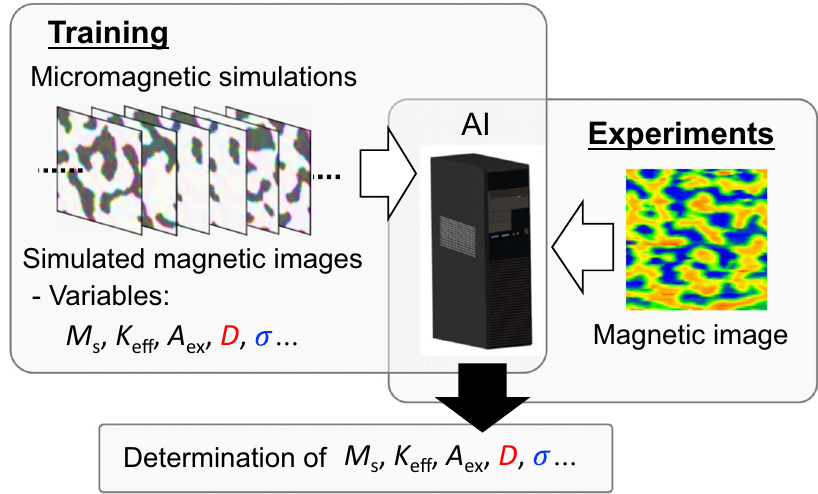
Fig. 1 Concept of the study. Micromagnetic simulations are used to generate thousands of training images. There are fi ve relevant material parameters: M s , K eff , A ex , D , and σ . Here we vary D and σ in the simulations so that the system can learn domain patterns with different D and σ . After the supervised training, we feed the system with an experimentally obtained image of magnetic domains to extract D and σ . Table 1. Summary of the material parameters used in micromagnetic